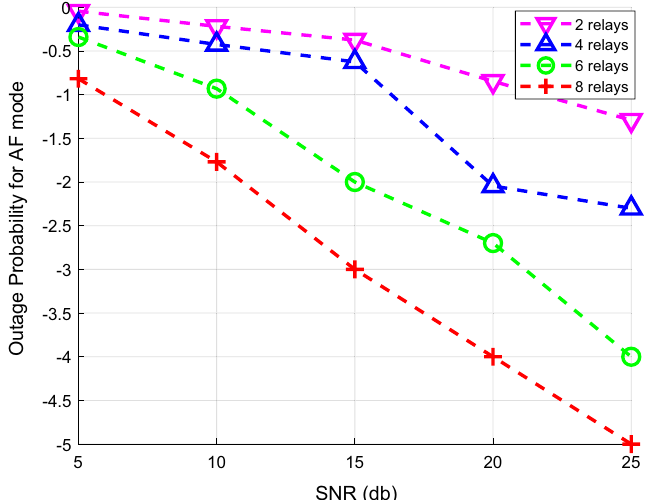
Fig. 10 Sum outage probability curve in AF relaying. It depicts the sum outage probability curve among different transmit SNRs and relays in two-way AF